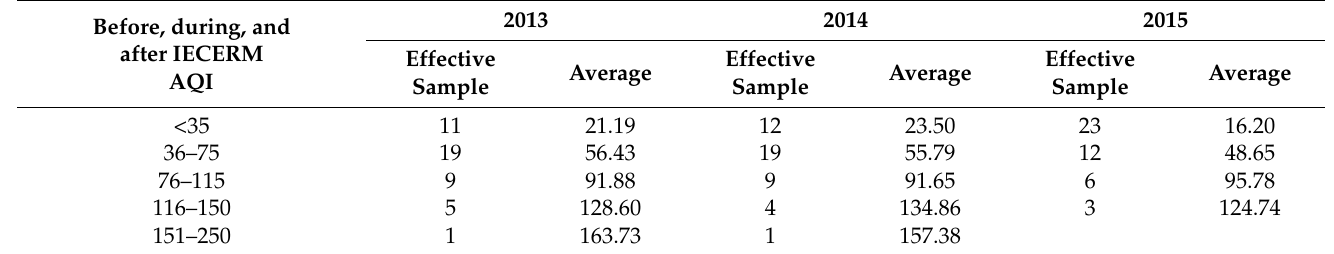
Table 4. Changes in AQI over the same period from 2013 to 2015 before, during, and after the IECERM. Before, during, and